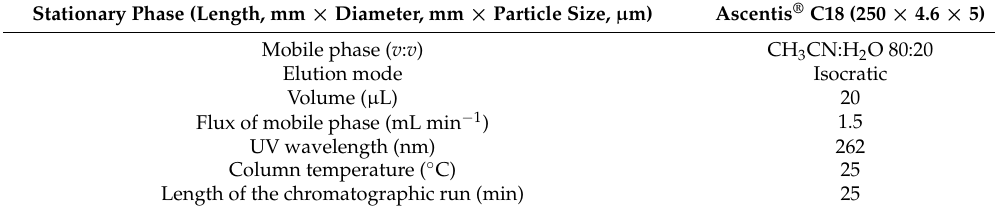
Table 2. Chromatographic conditions proposed for the contemporary RP-HPLC separation and quantification of guayulins A, B, C and D in resin extracts from Guayule biomass. Stationary Phase (Length, mm × Diameter, mm × Particle Size, µ